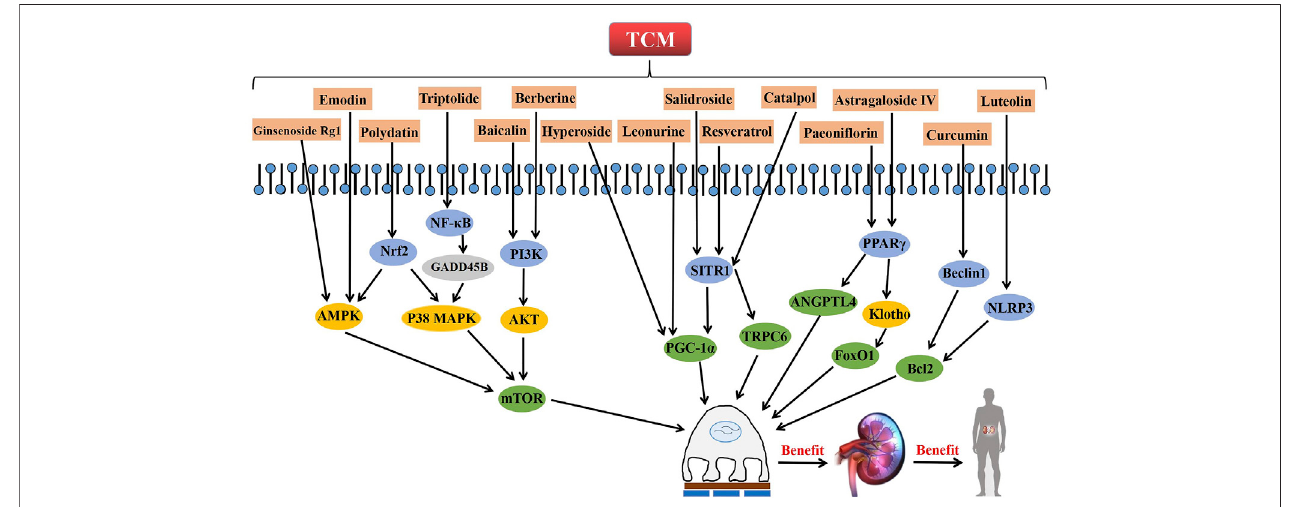
FIGURE 3 | The role and related signaling pathways of active ingredients from TCM in the repair of podocyte injury.